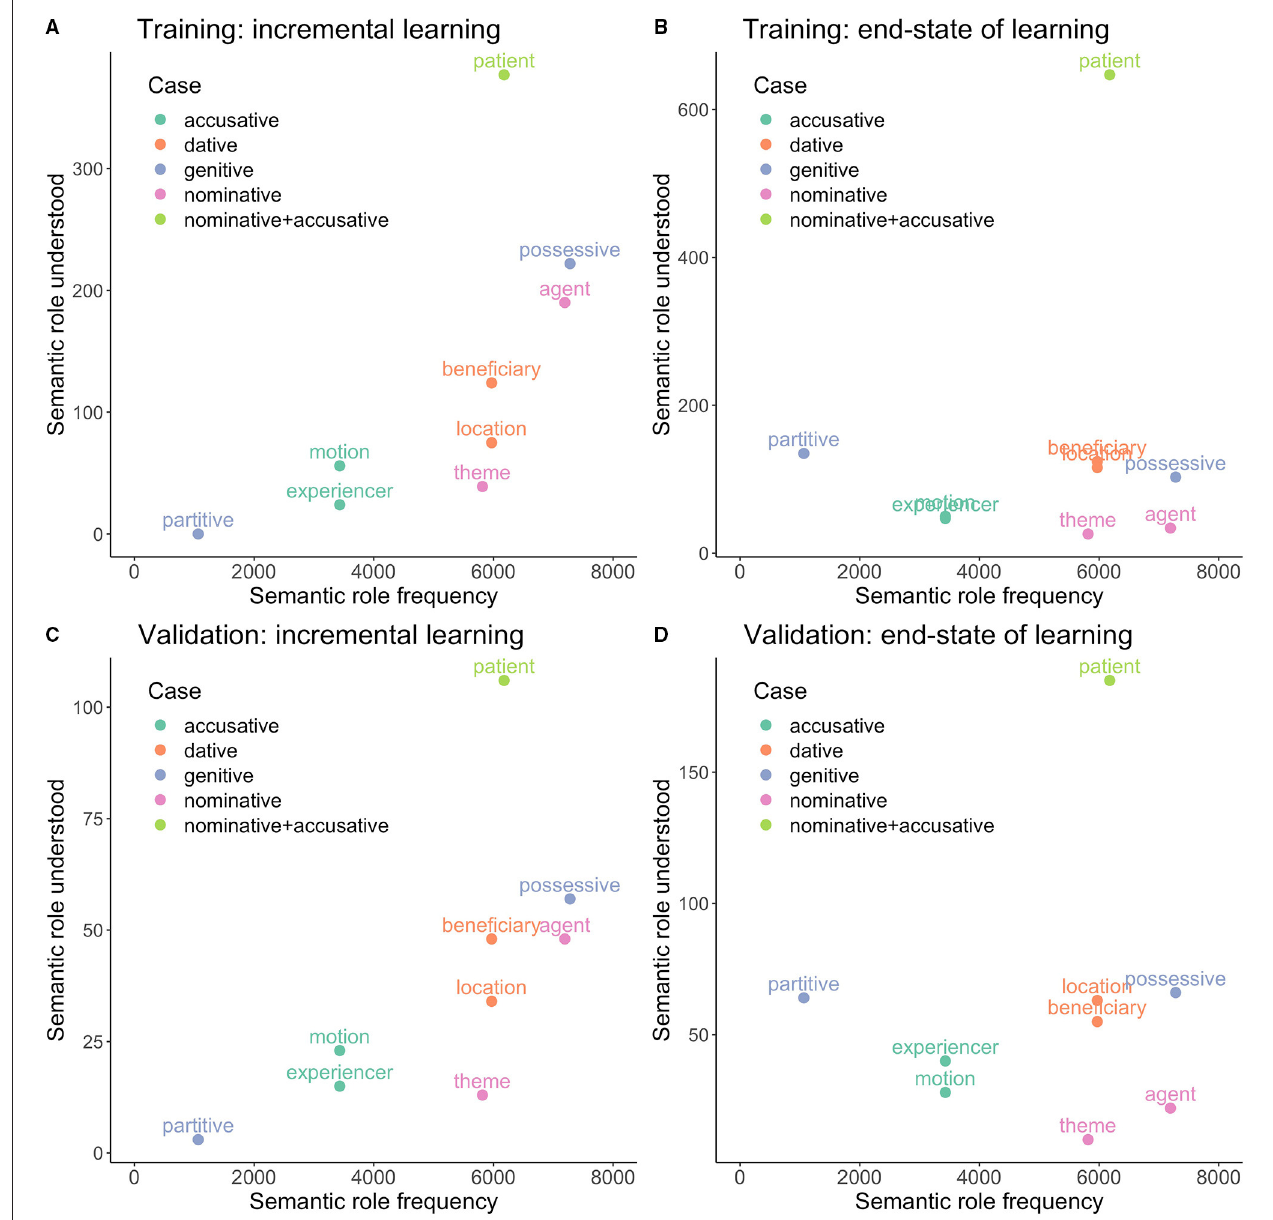
FIGURE 3 | Counts of overgeneralization errors of semantic roles for training (top) and test data (bottom), for incremental learning (left) and the end-state of learning (right), conditional on the model having understood lexeme, number, and case correctly. (A) Training: incremental learning. (B) Training: end-state of learning. (C) Validation: incremental learning. (D) Validation: end-state of